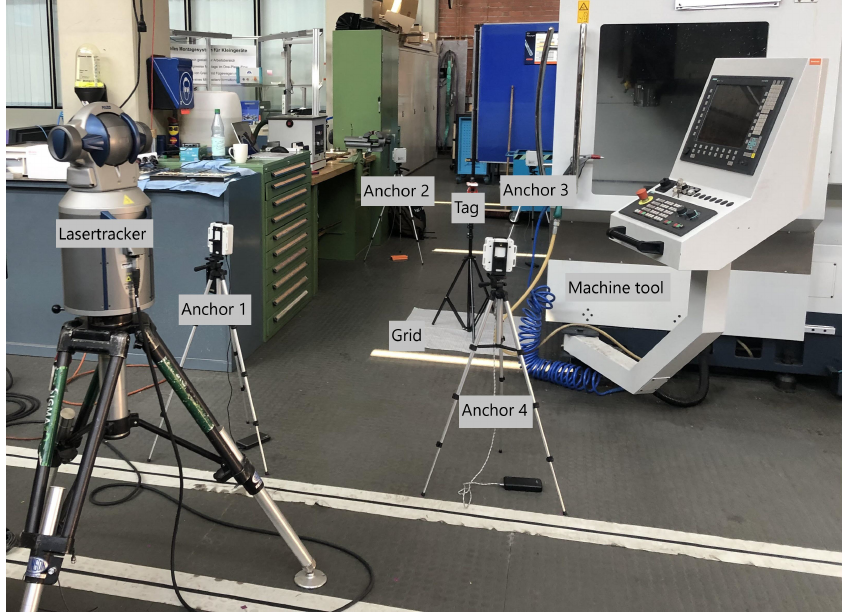
Figure 3. Setup with laser